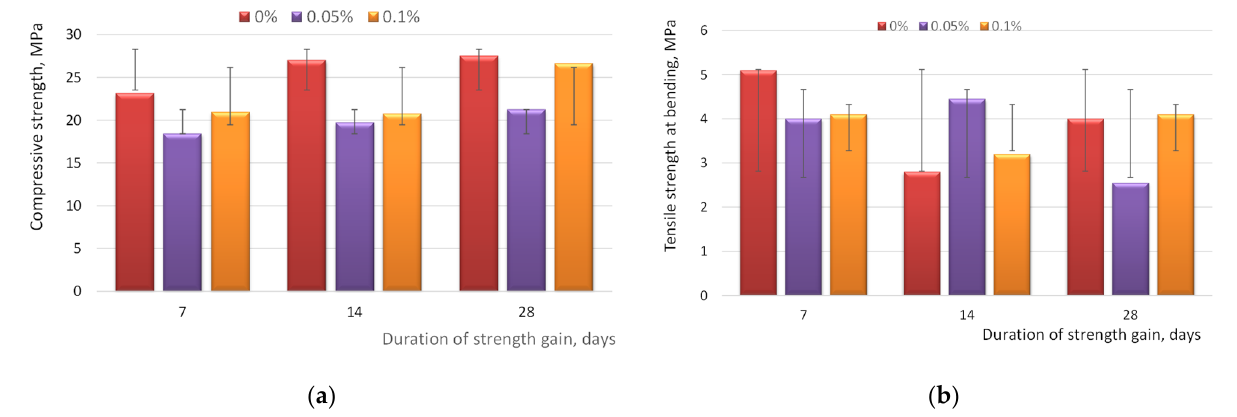
Figure 10. The effect of CNPLUS content on the strength parameters of concrete mortar: ( a ) compressive strength; ( b ) tensile strength during bending.